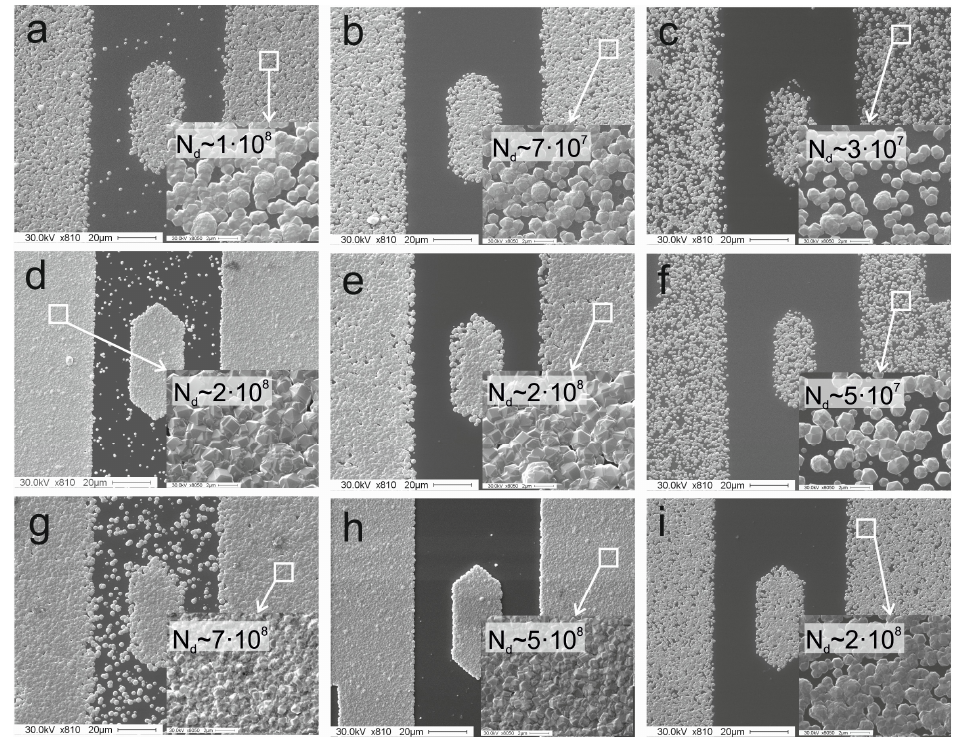
Figure 3. SEM images of the diamond film topography surface seeding by ( a – c ) 0.15 wt % of nanodiamond in photoresist, ( d – f ) 0.3 wt %, ( g – i ) 0.45 wt % and with different durations of reactive ion etching: ( a , d , g ) without etching; ( b , e , h ) 4 min; ( c , f , i ) 30 min.